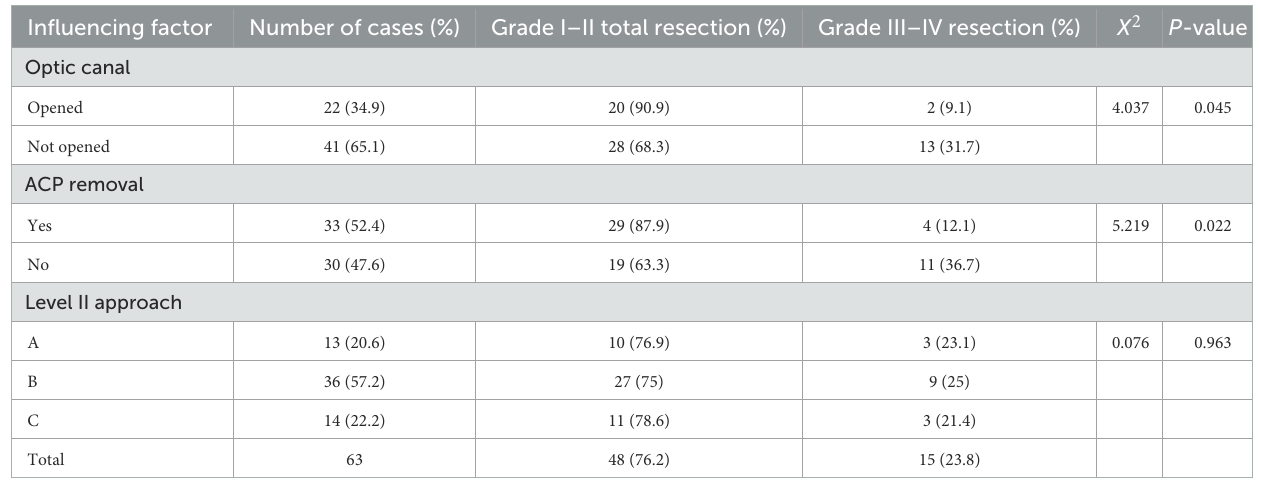
TABLE 4 Relationship between intraoperative treatment and extent of tumor resection